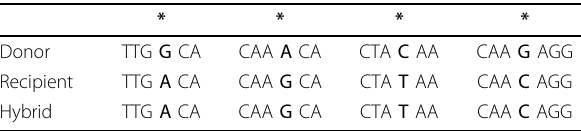
Table 2 Mitochondrial sequence analysis of monkey hybrid stem